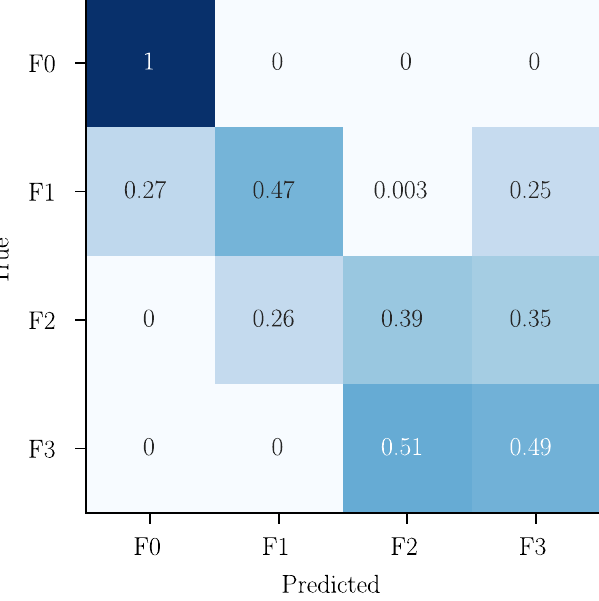
Figure 8. Confusion matrix for the target dataset FDD obtained with a model trained using only the source dataset samples and then applying the dissimilarity reduction step (Source →